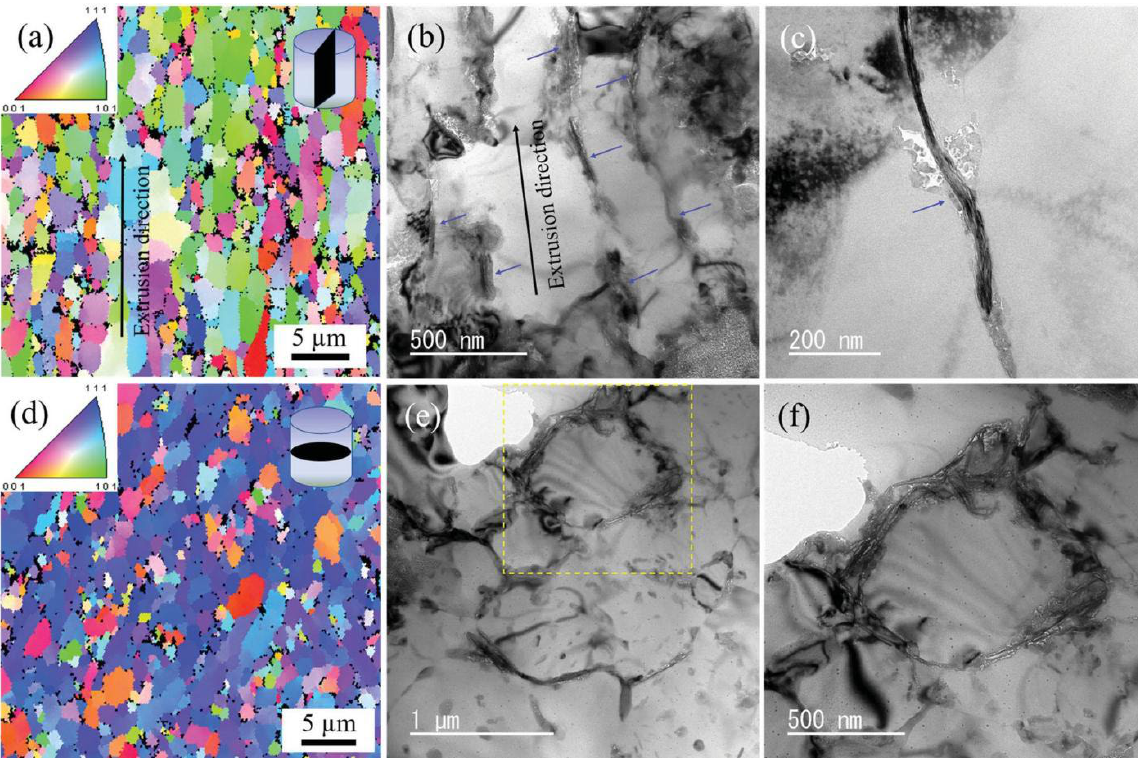
Figure 11. Microstructures of the 0.26 vol.% FLM/Al composite in the ( a – c ) longitudinal and ( d – f ) transverse cross-sections: ( a , d ) EBSD-IPF maps; ( b , c , e , f ) TEM images. ( f ) is taken from the yellow square in ( e ). Reprinted with permission from [68]. Copyright 2020 Taylor and Francis.